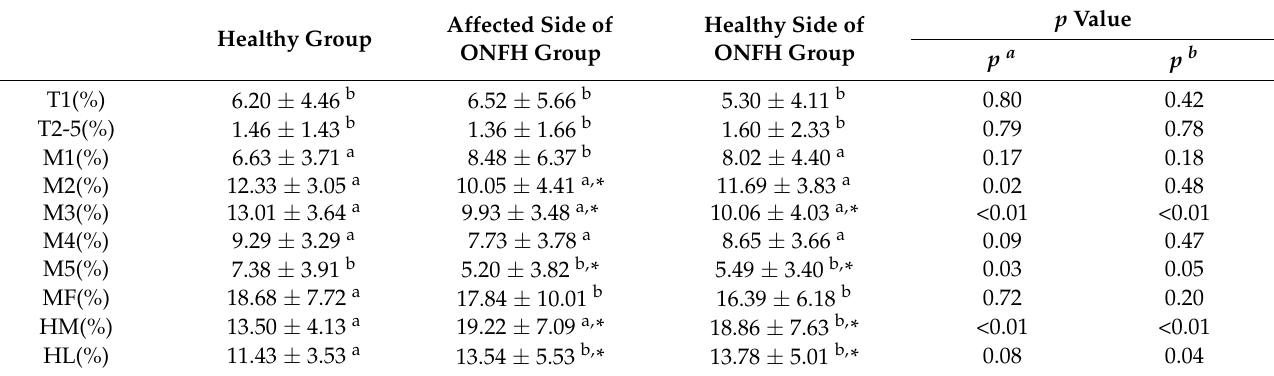
Table 5. Regional impulse percentage (%) in different regions of ONFH and healthy groups. Healthy Group